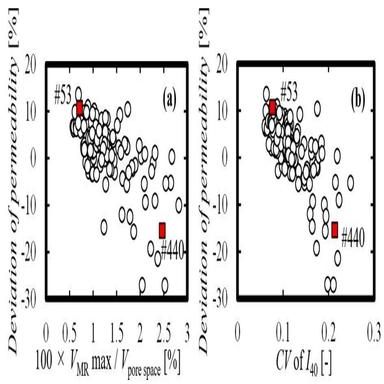
Relationships between the deviation index of the permeability and the descriptors: (a) VMR max and (b) CV of I40.